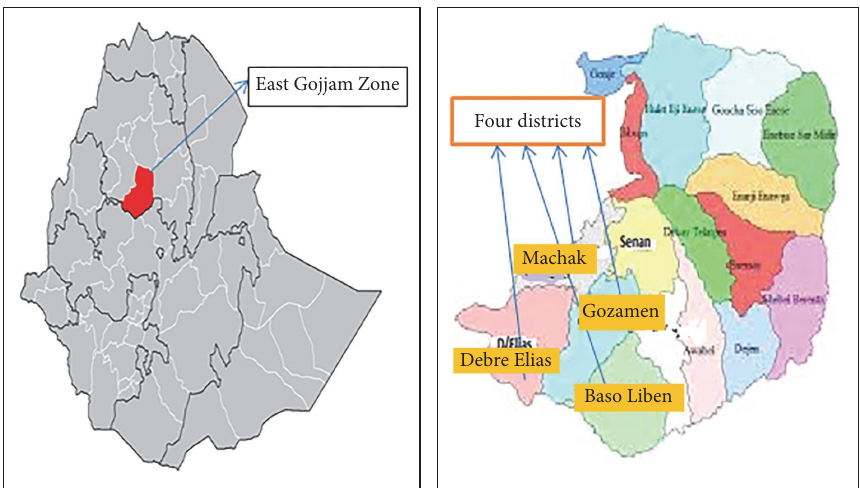
F IGURE 3: Map of Ethiopia showing the relative location of East Gojjam Zone and the selected districts of East Gojjam